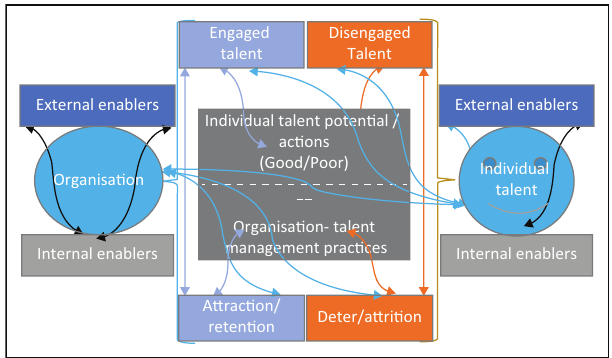
FIGURE 2: The interface between talented employees and the